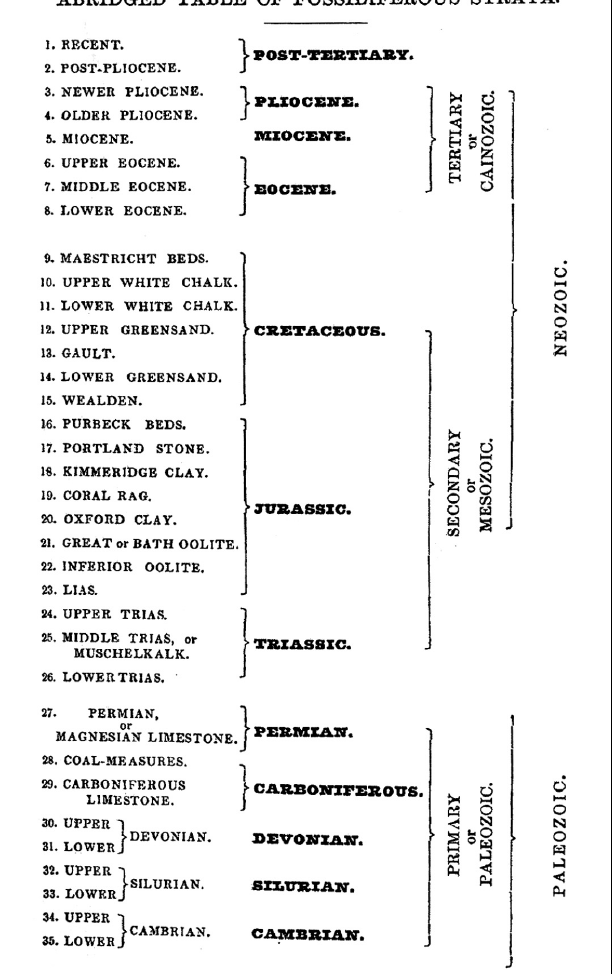
FIGURE 2 | The chronostratigraphic chart of Lyell (1855, p. 109), an “abridged table of fossiliferous strata.” According to Head et al. (2017, p. 4), “probably the first-ever multi-hierarchical chronostratigraphic chart.” Reproduced by kind permission of the Syndics of Cambridge University Library.